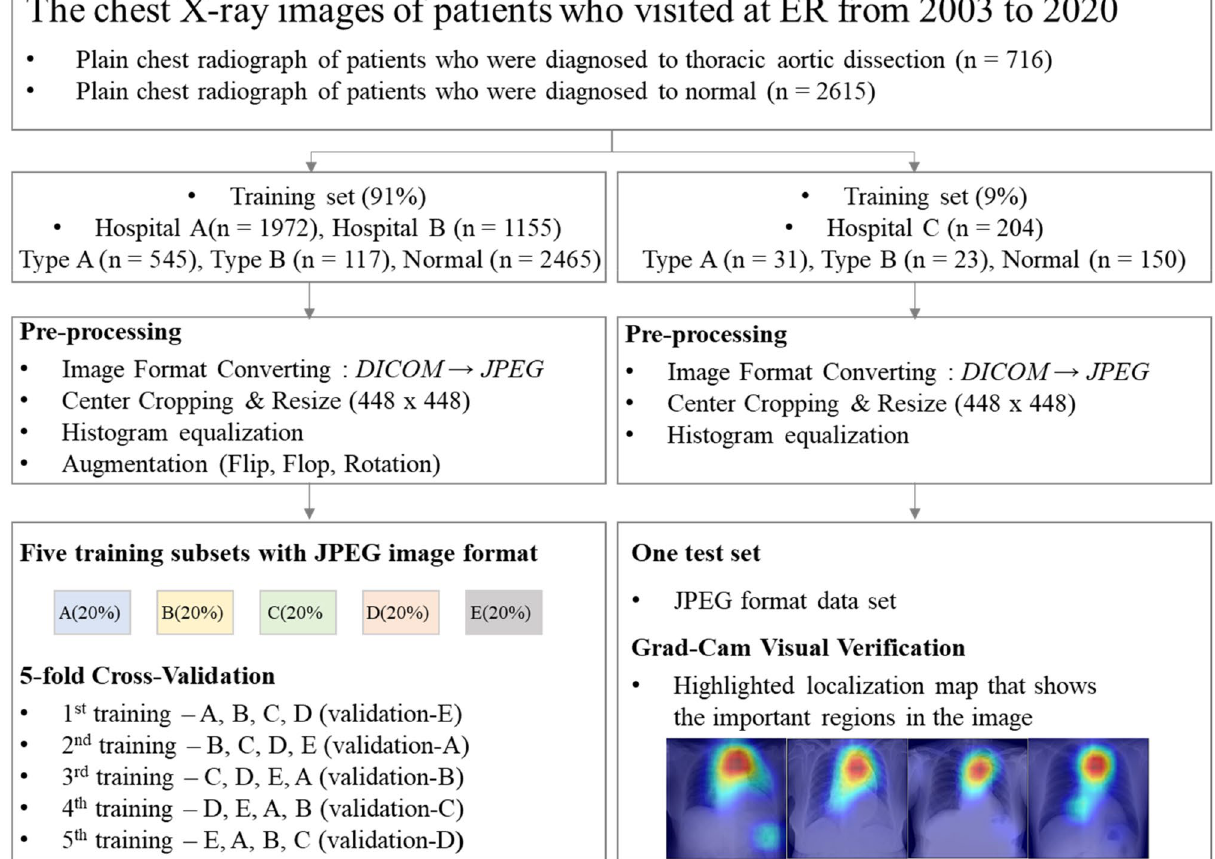
Figure 5. Flow chart of data collection and analysis during acute thoracic aortic dissection detection based on deep learning